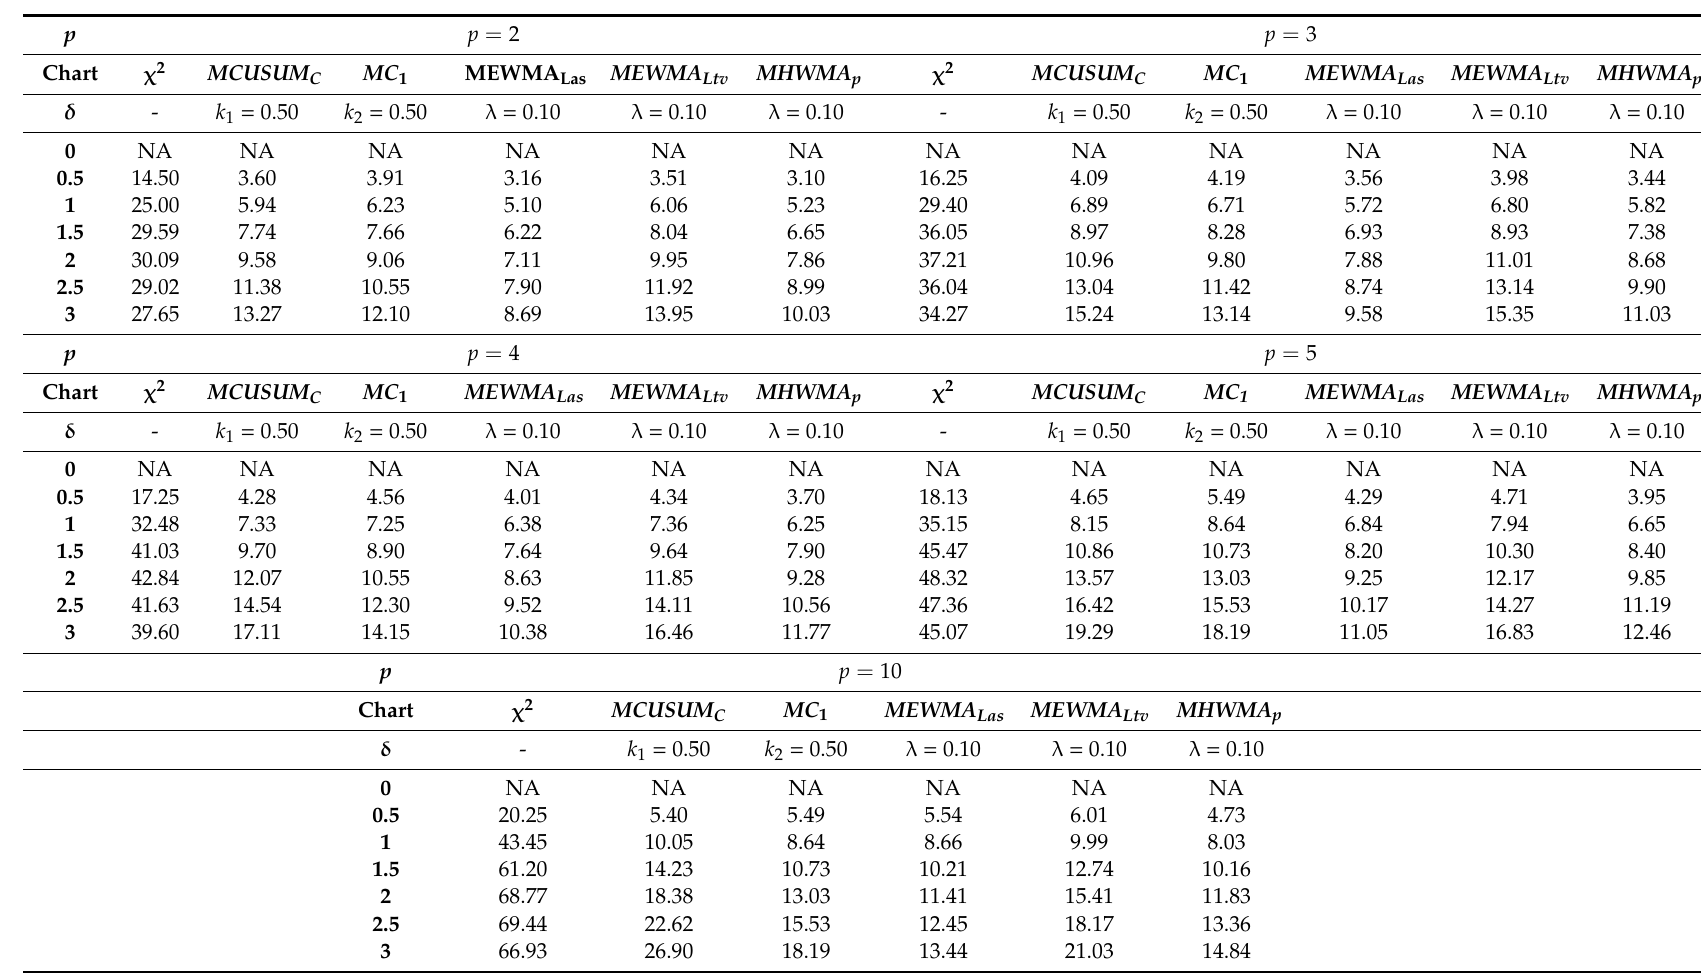
Table 1. Cumulative extra quadratic loss (EQL) values for di ff erent charts. MEWMA, multivariate exponential weighted moving average; MHWMA, multivariate homogeneously weighted moving average; MCUSUM, multivariate